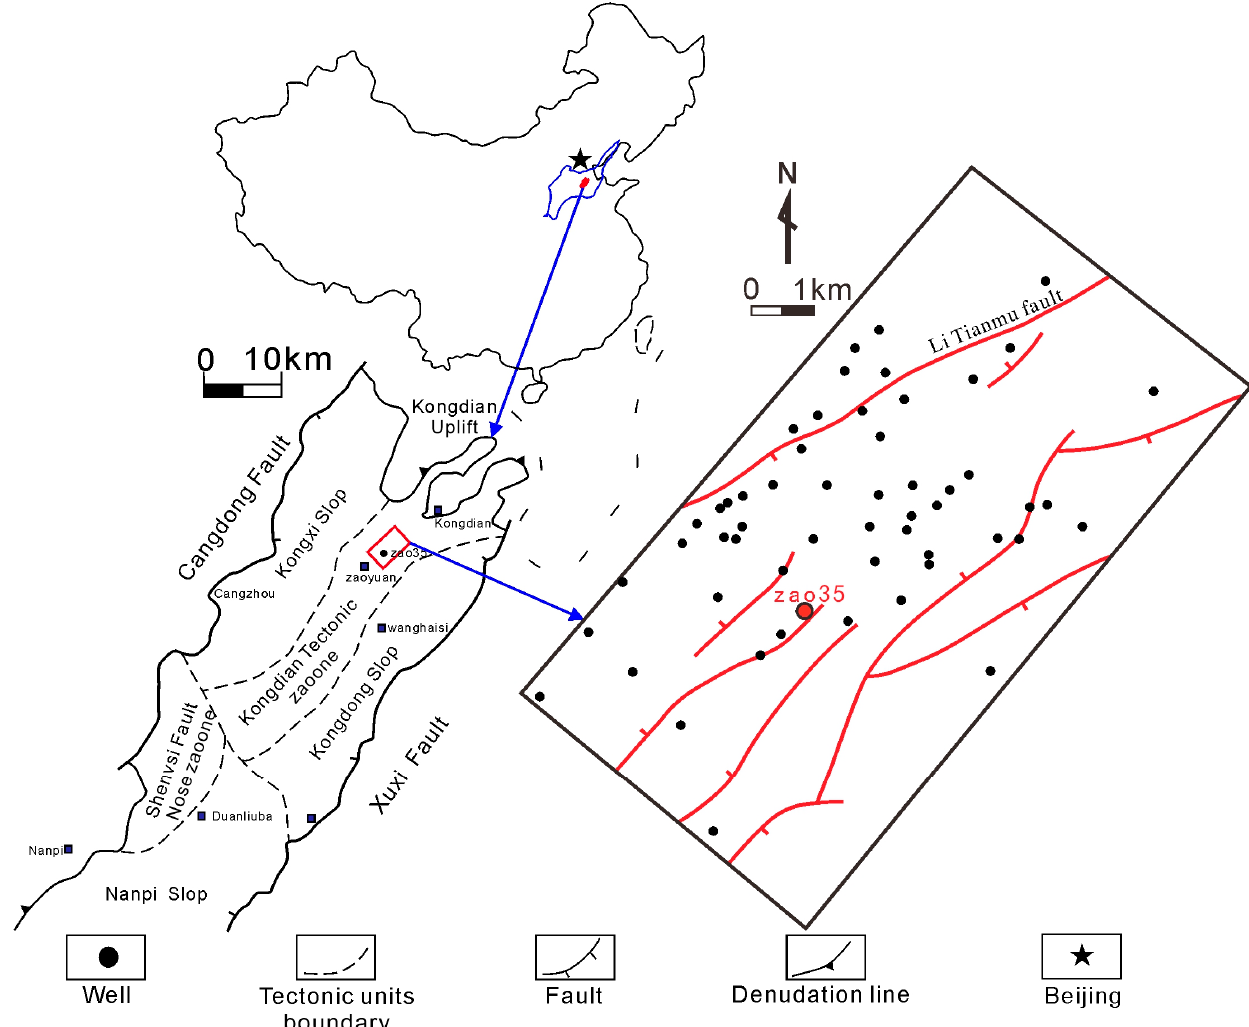
Figure 1. Tectonic setting and location of the Zao35